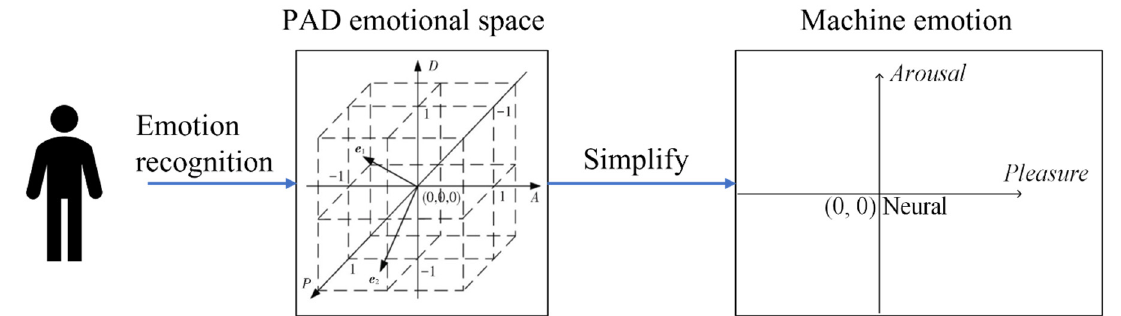
Figure 1. Emotional space for machine emotion.